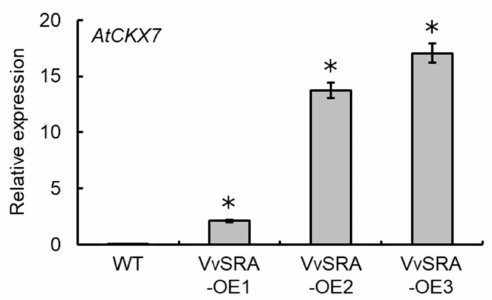
Figure 2. Upregulation of AtCKX7 in VvSRA-overexpressing plants. Total RNA was isolated from 12-day-old seedlings and subjected to real-time RT-PCR. Actin was used as an internal control. Data were calculated as gene expression level relative to actin gene expression level. Bars indicate means ± standard deviations of three seedlings. * p < 0.01 compared with wild type (Dunnett’s test). VvSRA-OE1, -OE2, and -OE3 were VvSRA-overexpressing Arabidopsis plants prepared in our previous study [13]. WT, wild